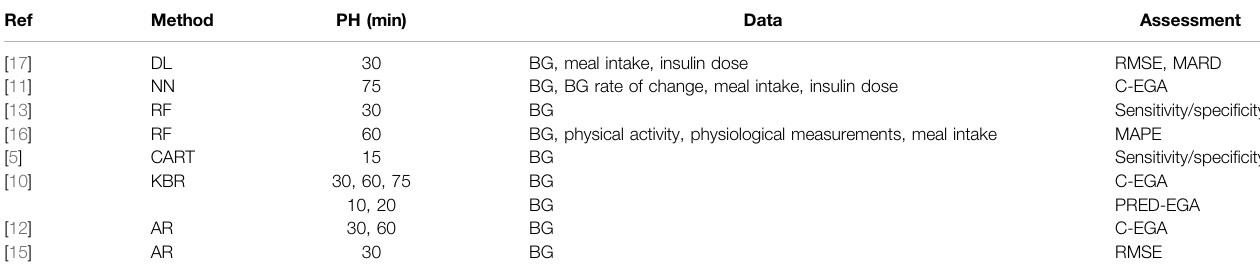
TABLE 1 | A summary of related work on BG prediction.